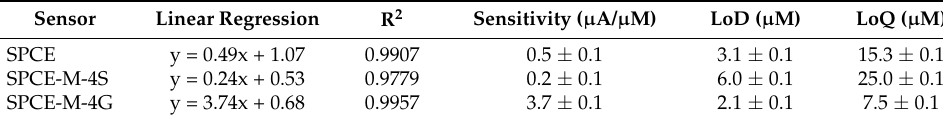
Figure 10. Voltammogram sample F and sample F + 7 µM standard of p -AP.